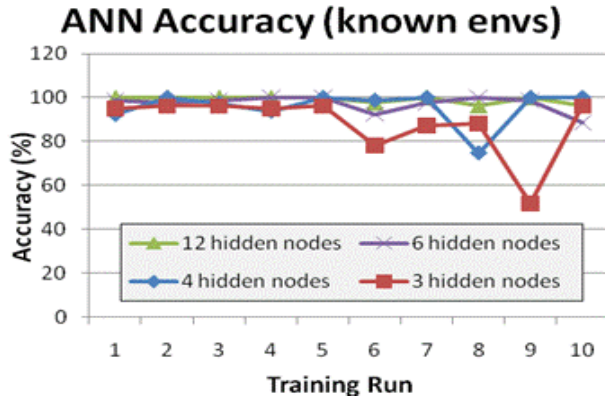
Fig. 2: ANN Accuracy for Known Environments 100% accurate classification was generated at least once with all hidden node configurations except when using 3 hidden nodes. The ANN with 12 hidden nodes provided the best accuracy across all the training runs— 100% accuracy all but 3 times out of 10 which would make it more likely to provide 100% accuracy for any single training run. However, once a single 100% accu- rate classification has been found it provides the maxi- mum accuracy. Therefore we chose the ANN with 4 hidden nodes since it has the lowest response time as shown in Sec. 5.2.